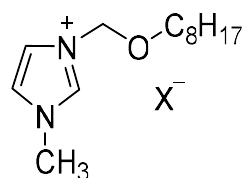
Figure 1. General Structure of New ILs.